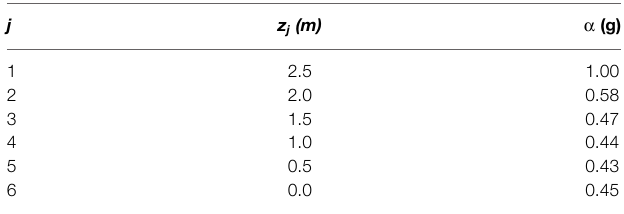
T ABLE 3 | Values of α for various locations of the horizontal cylindrical hinge for the first out-of-plane mechanism. j z j (m) α